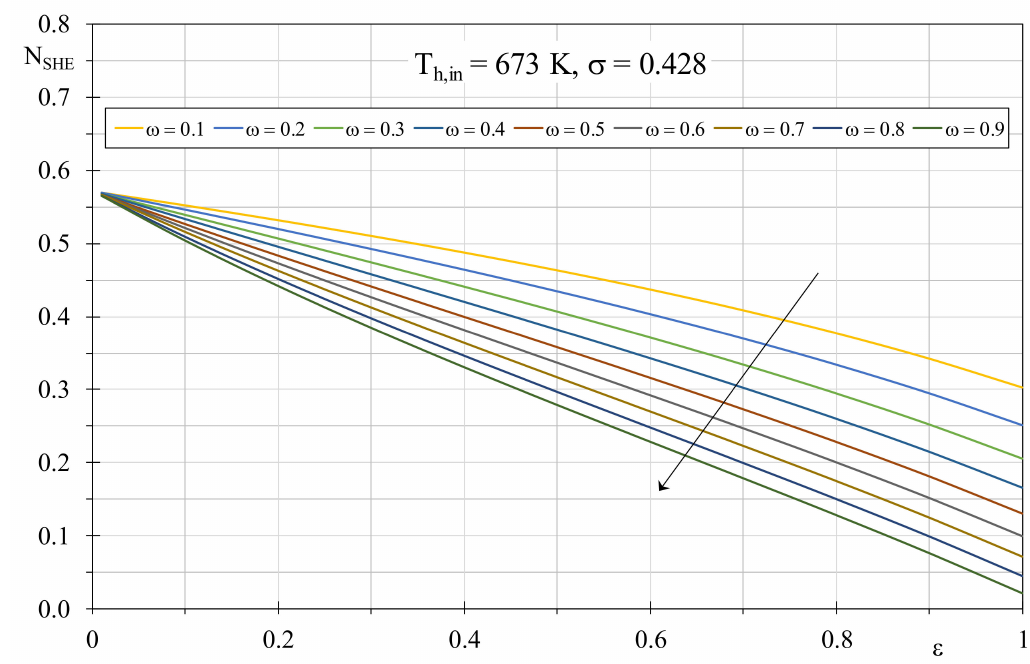
Figure 2. EGN for an unbalanced heat exchanger operating in counter-current related to the efficiency, the thermal capacity ratio, by setting cold and hot fluid inlet temperatures of 288 K and 673 K, respectively, and the maximum thermal capacity for the cold fluid.